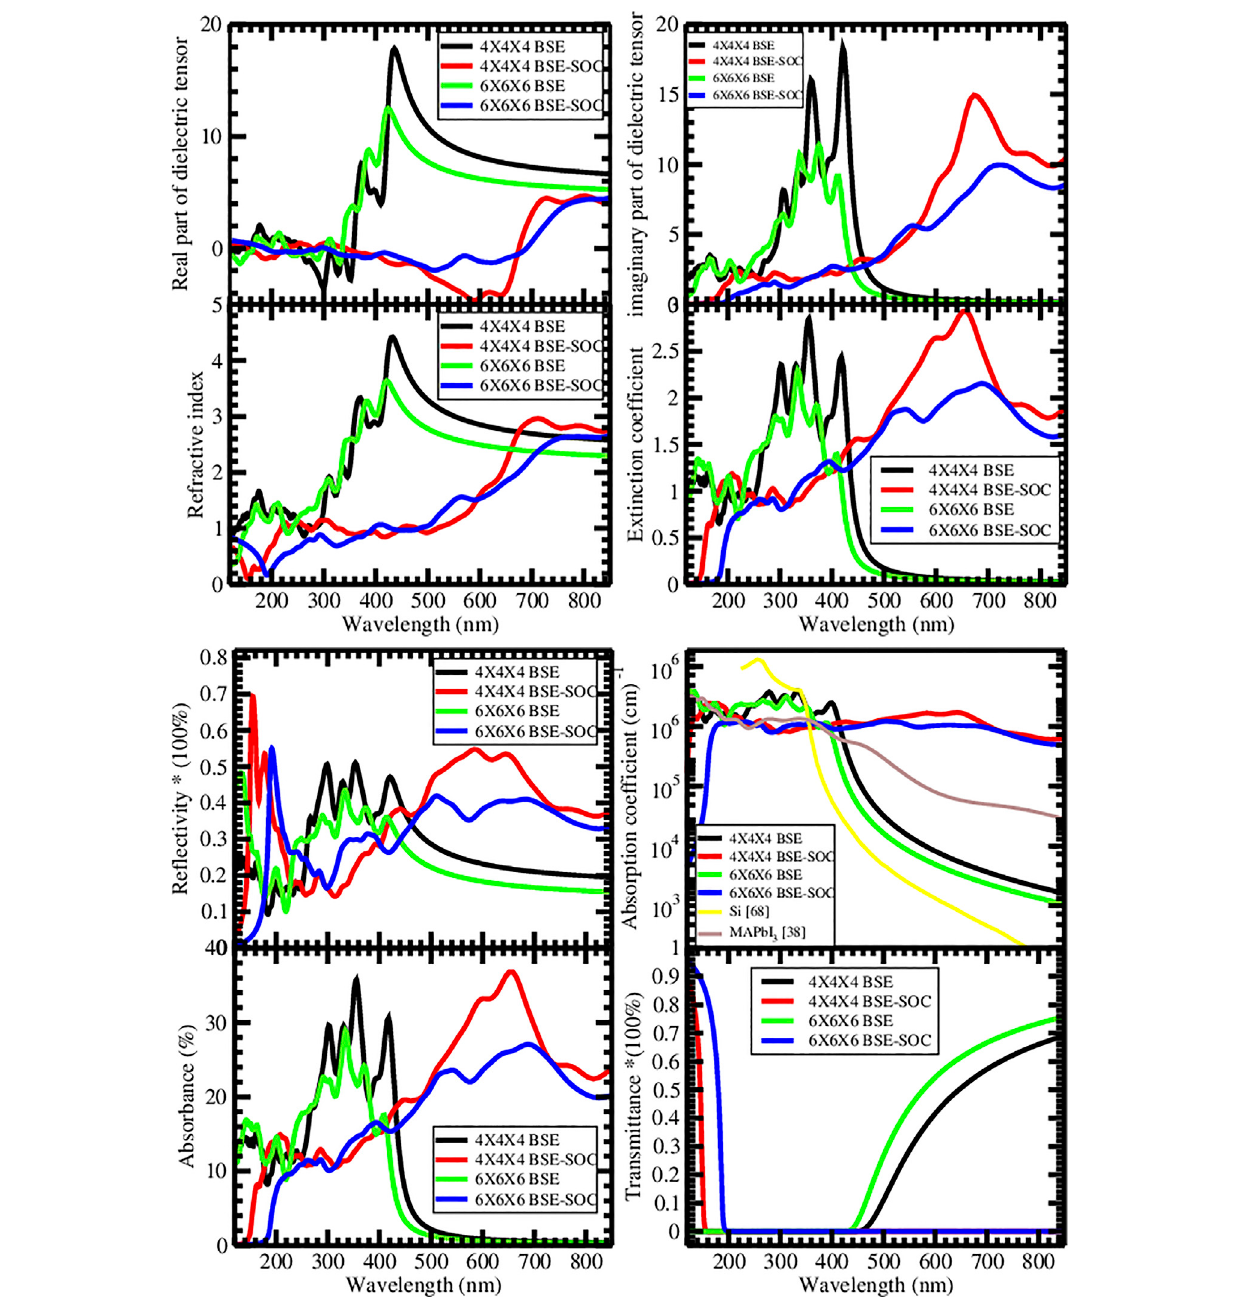
FIGURE4 | Optical spectraof pseudo-cubicCH 3 NH 2 CH 3 PbI 3 . (A) Real part ofthe dielectric tensor. (B) Imaginary part of the dielectric tensor. (C) Refractive index (n). (D) Extinction coef fi cient (k). (E) Re fl ectivity. (F) Absorption coef fi cient. (G) Absorbance. (H) Transmittance.